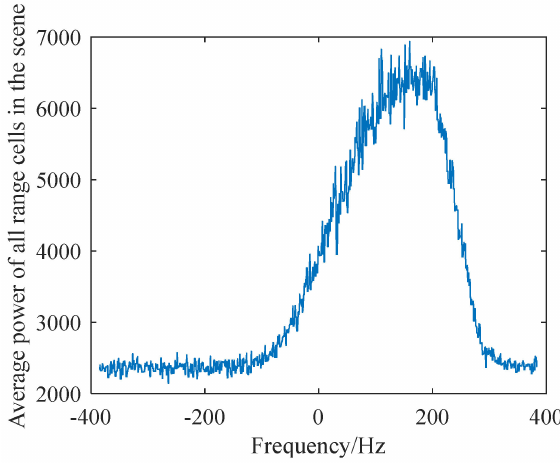
Figure 12. Average power spectrum of all range cells in the scene.